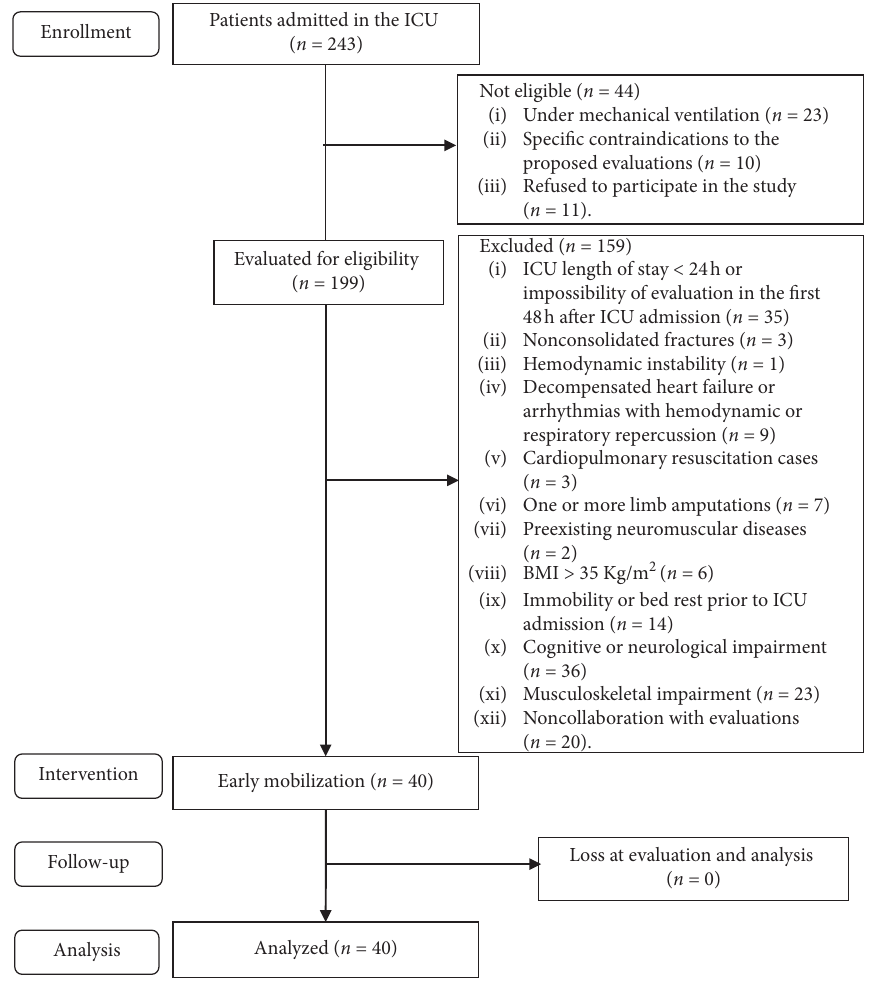
Figure 2: Flowchart of patients’